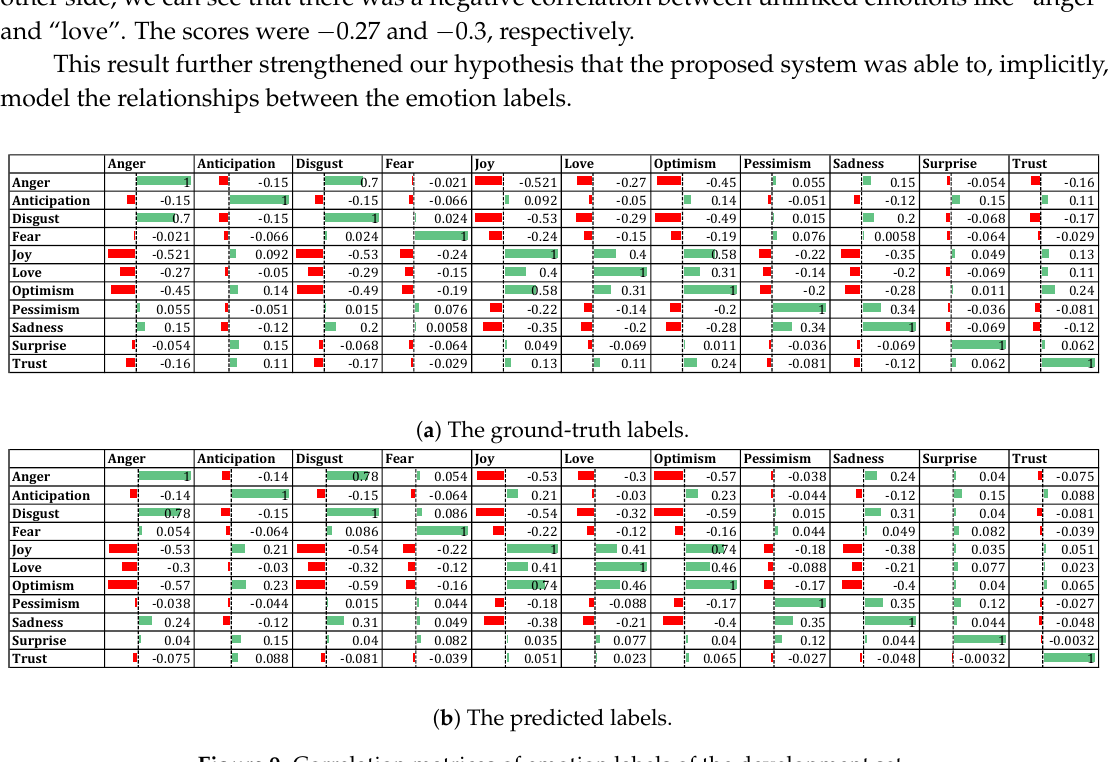
Figure 9. Correlation matrices of emotion labels of the development